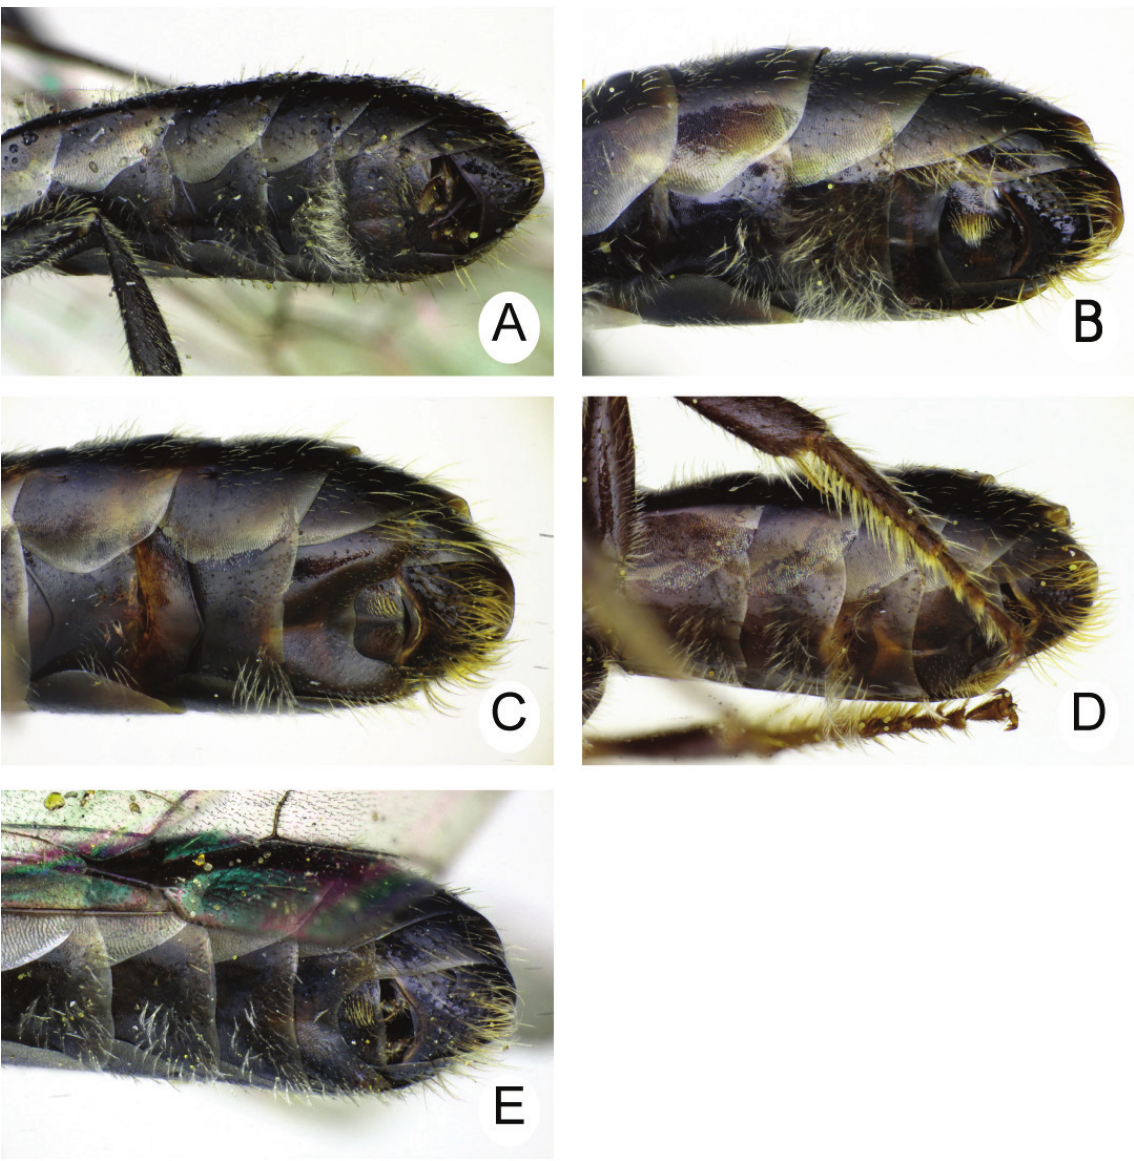
Fig. 4. hairs on metasomal sterna in species of the atroglaucum subgroup, ♂. A . Lasioglossum ( Dialictus ) atroglaucum (Strand, 1913). B . Lasioglossum ( Dialictus ) virideglaucum ebmer & Sakagami, 1994. C . Lasioglossum ( Dialictus ) yamanei Murao et al ., 2006. D . Lasioglossum ( Dialictus ) negoroi Murao & Tadauchi, 2008, holotype. E . Lasioglossum ( Dialictus ) taiwanense Murao sp. nov.,